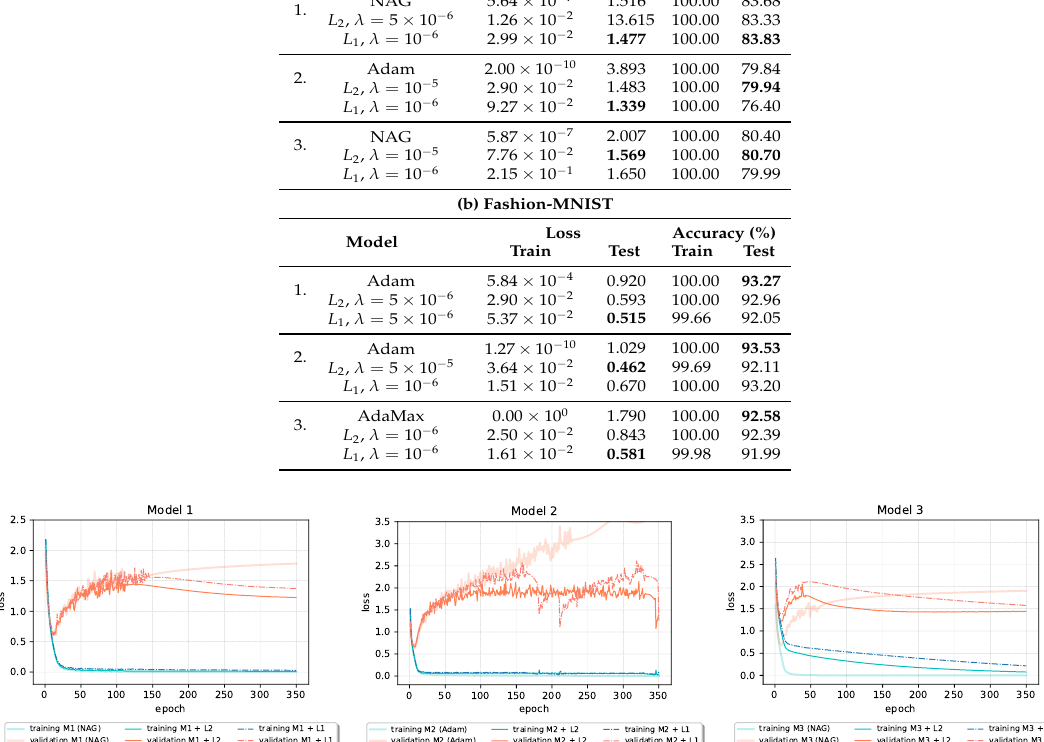
Figure 7. Loss learning curves of models that incorporate L 2 and L 1 weight decay in baseline models trained on CIFAR-10